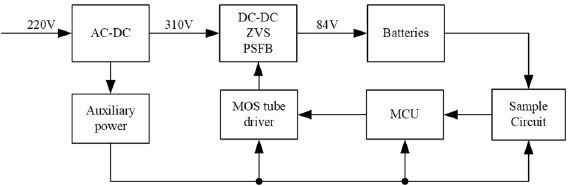
Figure 1. The charger structure of electric vehicle.